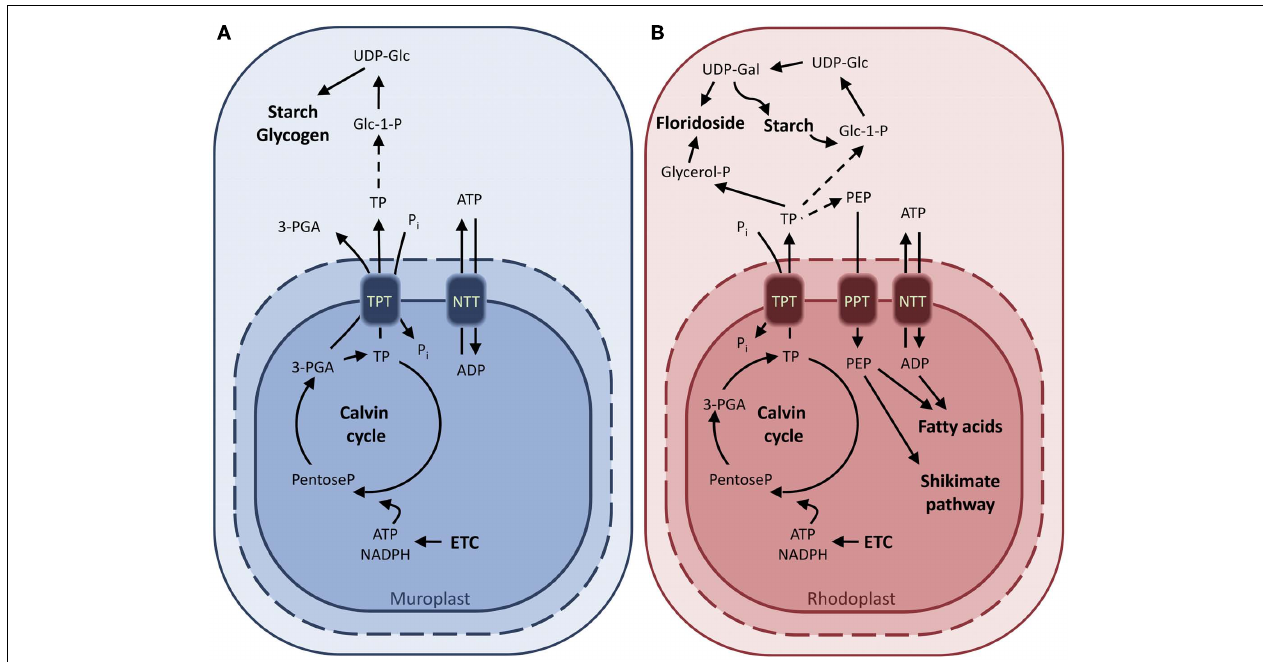
FIGURE 3 | Characterized and putative metabolite transporters of the glaucophaye Cyanophora paradoxa (A) and the rhodophyte Galdieria sulphuraria (B). Proposed model of carbon export from C. paradoxa based on uptake experiments with isolated cyanelles.The identity of the transporter responsible for theTPT activity is not elucidated yet (A) . Characterized metabolite transporters of G. sulphuraria and their substrate specificities.The GsTPT, unlike for the green plant chloroplasts, is unable to transport 3-PGA pointing to the presence of an alternate reduction shuttle in the red algae (B)